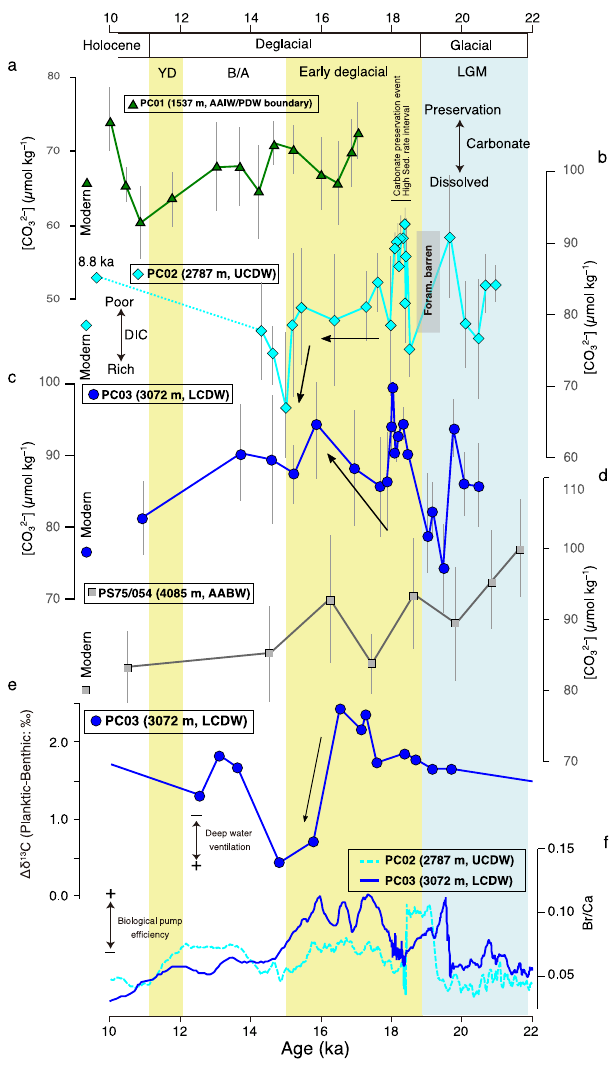
Fig. 3 | Reconstruction of deep-water [CO 3 2 − ] during 10 – 22 ka BP. a PC01, b PC02, c PC03,and d PS75/054. e Differenceinstablecarbonisotoperatio( Δδ 13 C) betweenplankticandbenthicforaminifera,and f Br/CaratioinPC02andPC03.YD Younger Dryas, BA Bølling-Allerød, LGM Last Glacial maximum, DIC Dissolved inorganic carbon, UCDW Upper Circumpolar Deep Water, LCDW Lower Cir- cumpolar Deep